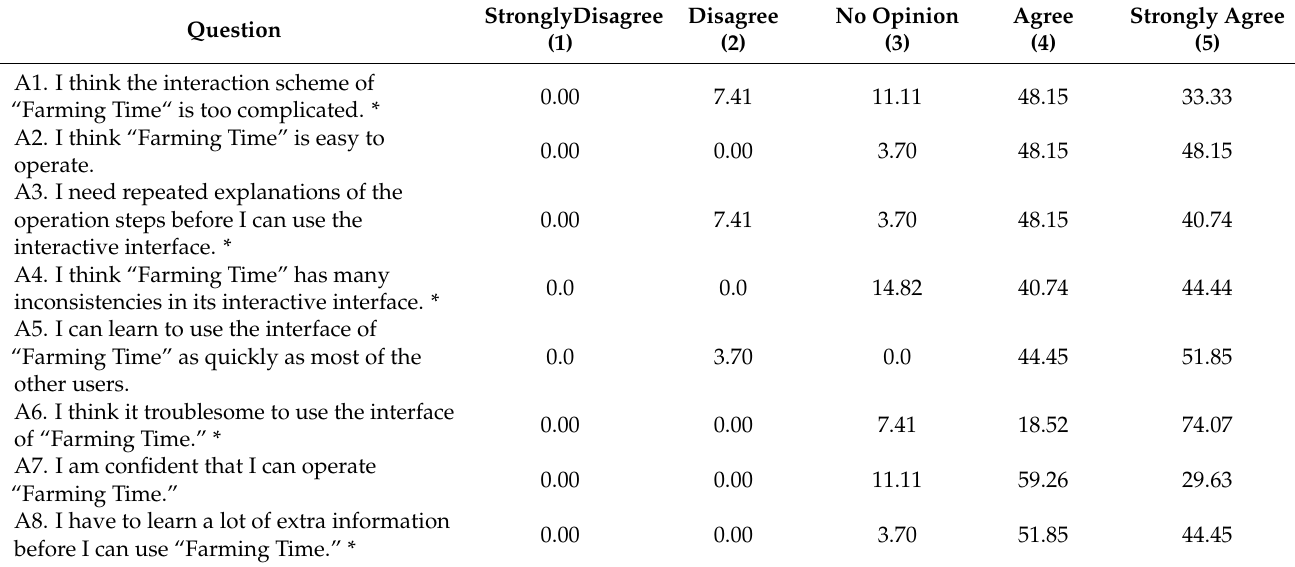
Table A1. Statistics of the Likert scores of the users’ answers to the questionnaire survey for the aspect of system usability (unit: %; score: